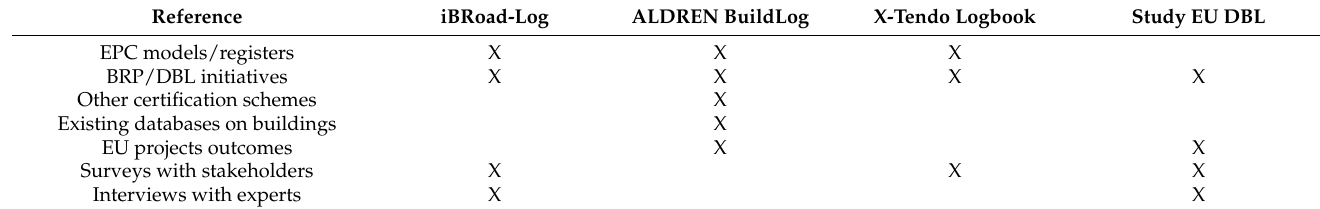
Table 3. References used as a starting point for the models’